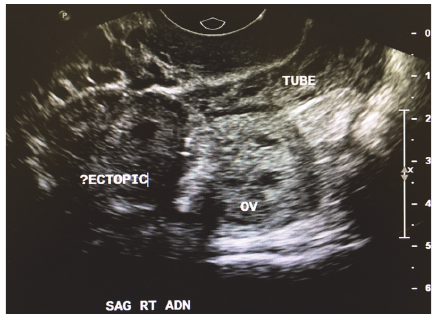
Figure 1: Transvaginal ultrasound of right adnexa.